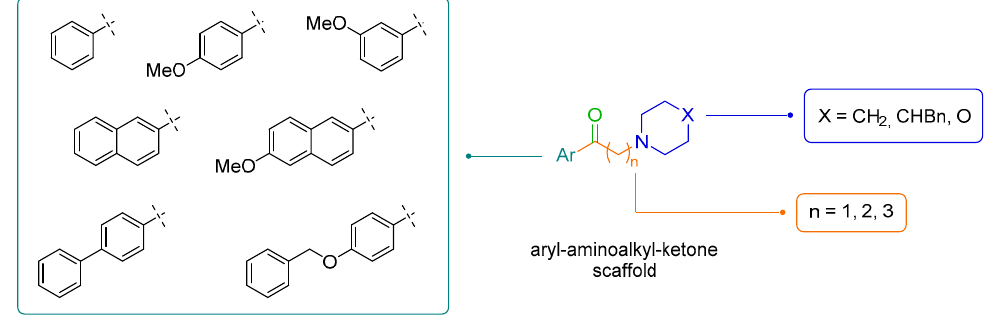
Figure 1. General scaffold of the published aryl-aminoalkyl-ketone series [15] and elements of structural differentiation suitable for the development of new analogs.